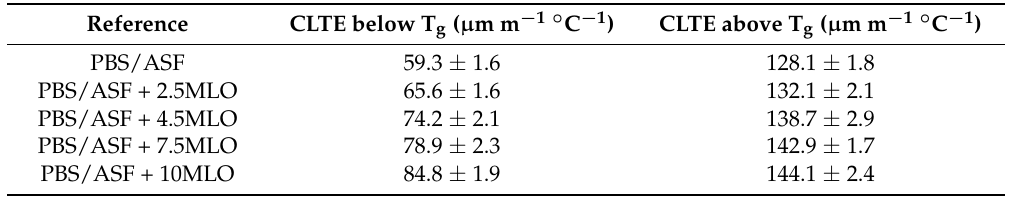
Table 5. Variation of the coefficient of linear thermal expansion (CLTE) of neat PBS and PBS/ASF composites with different MLO compatibilizer content.